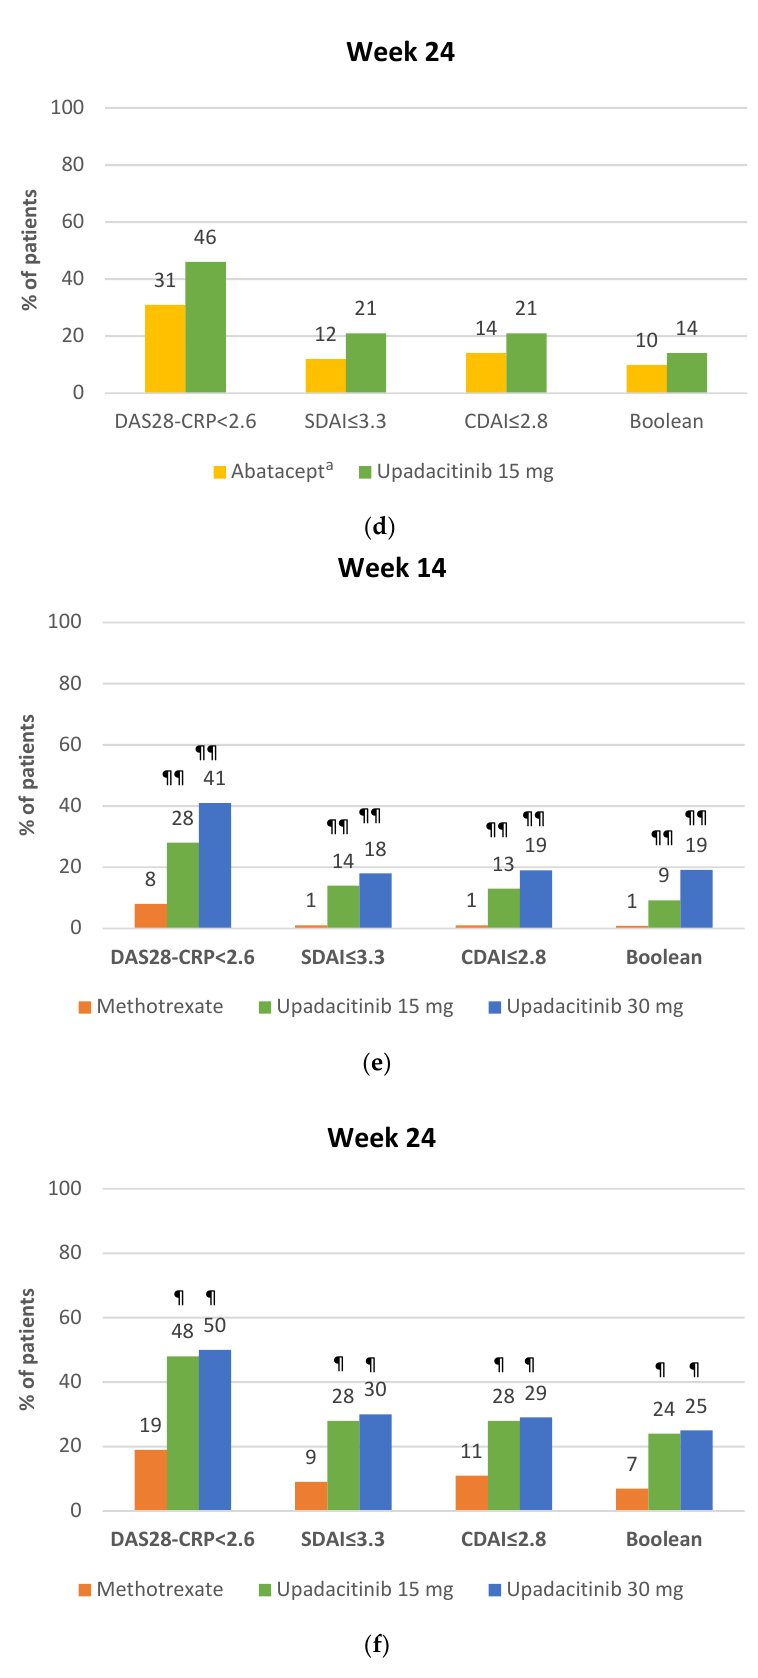
Figure 2. ( a ) Clinical remission with upadacitinib in the SELECT-NEXT trial [21]. * p < 0.05 for upadacitinib vs. placebo. ** p < 0.01 for upadacitinib vs. placebo. † p < 0.001 for upadacitinib vs. placebo. ‡ p < 0.0001 for upadacitinib vs. placebo. ( b ) Clinical remission with upadacitinib in the SELECT-COMPARE trial at week 26 [23]. † p < 0.001 upadacitinib vs. placebo. ¶ p < 0.001 upadacitinib vs. adalimumab. ( c ) Clinical remission with upadacitinib in the SELECT-COMPARE trial at week 156 [36]. p < 0.05 upadacitinib versus adalimumab. p < 0.01 upadacitinib versus adalimumab. ¶ p < 0.001 upadacitinib versus adalimumab. ( d ) Clinical remission with upadacitinib in the SELECT- CHOICE trial [24]. a No statistical testing was performed. ( e ) Clinical remission with upadacitinib in the SELECT-MONOTHERAPY trial [25]. ¶¶ p < 0.0001 for upadacitinib versus methotrexate. ( f ) Clinical remission with upadacitinib in the SELECT-EARLY trial [26]. ¶ p < 0.001 for upadacitinib versus methotrexate. CDAI — clinical disease activity index; DAS28-CRP — disease activity score in 28 joints using C-reactive protein level; SDAI — simplified disease activity index. JAK inhibitors are involved in the interleukin-6 signaling pathway, which is a driver of acute phase inflammatory responses, including the induction of CRP [37]; therefore, it is also important to know the remission rates according to an outcome measure that does not include CRP, such as the clinical disease activity index (CDAI). Using the more strin- gent criteria of achieving a CDAI ≤ 2.8, remission rates with upadacitinib 15 mg were ap- proximately 10% at week 12 [21] and approximately 20% at week 24 – 26 [23,24]; differences